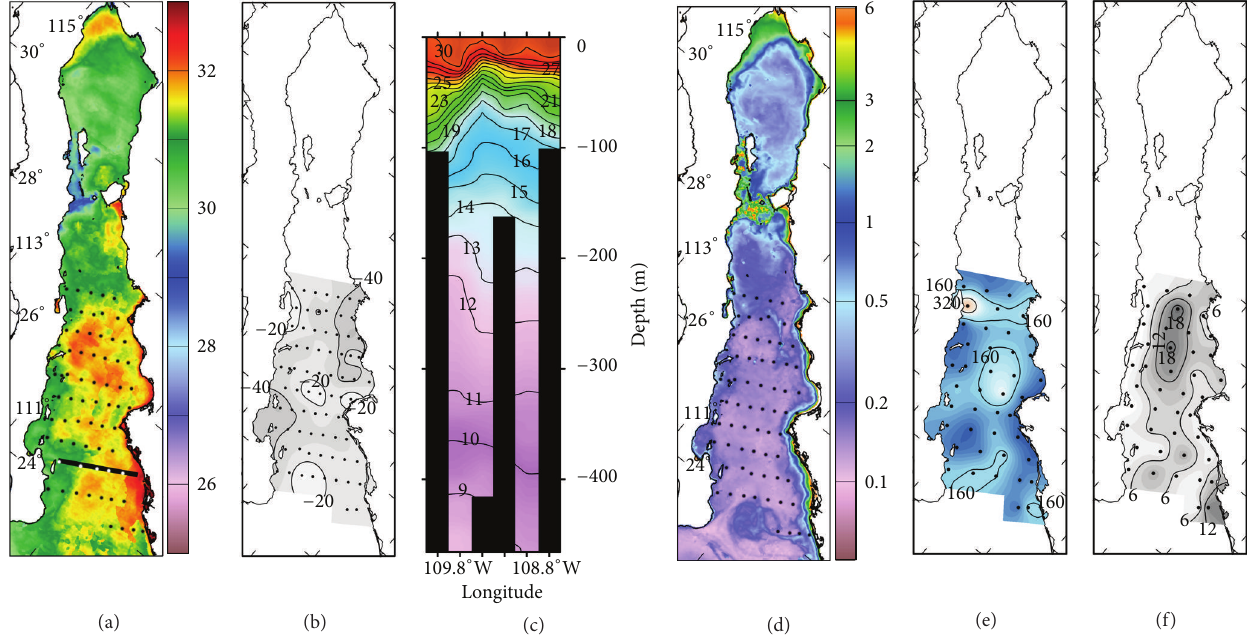
Figure 5: Biophysical characteristics during September. Composite of (a) SST ( ∘ C) and (d) CHL (mg m −3 ) satellite images of the Gulf of California. Black line in (a) indicates transect analyzed for water column profile. (c) Temperature profile ( ∘ C). Distribution of (b) maximum stability depth (MSD), (e) zooplankton volumes, and (f) species